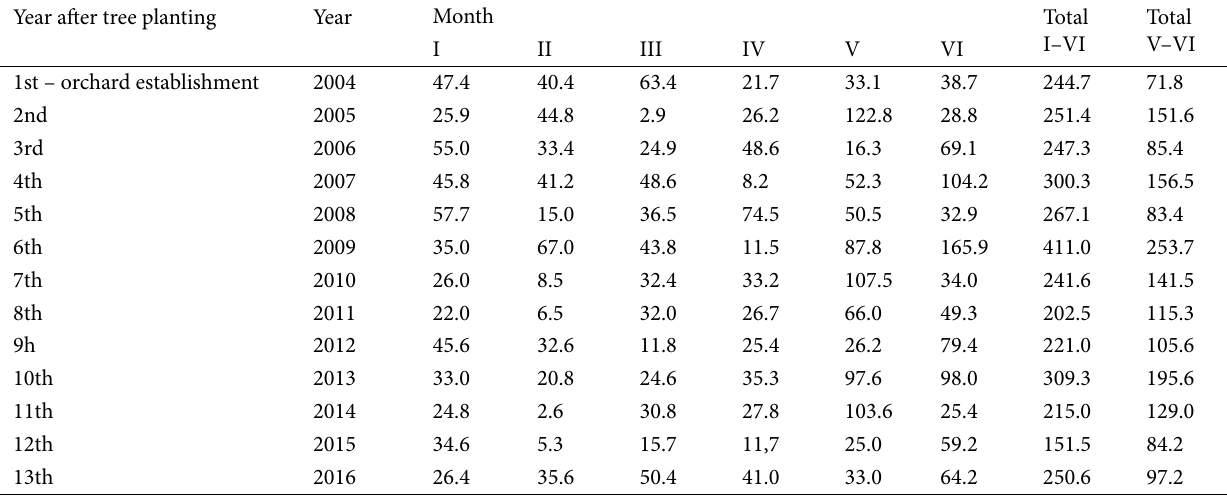
Table 1 Total precipitations (mm) during the first 6 months at the Fruit Experimental Station in Samotwór (51 E) in the years 2004 − 2016.